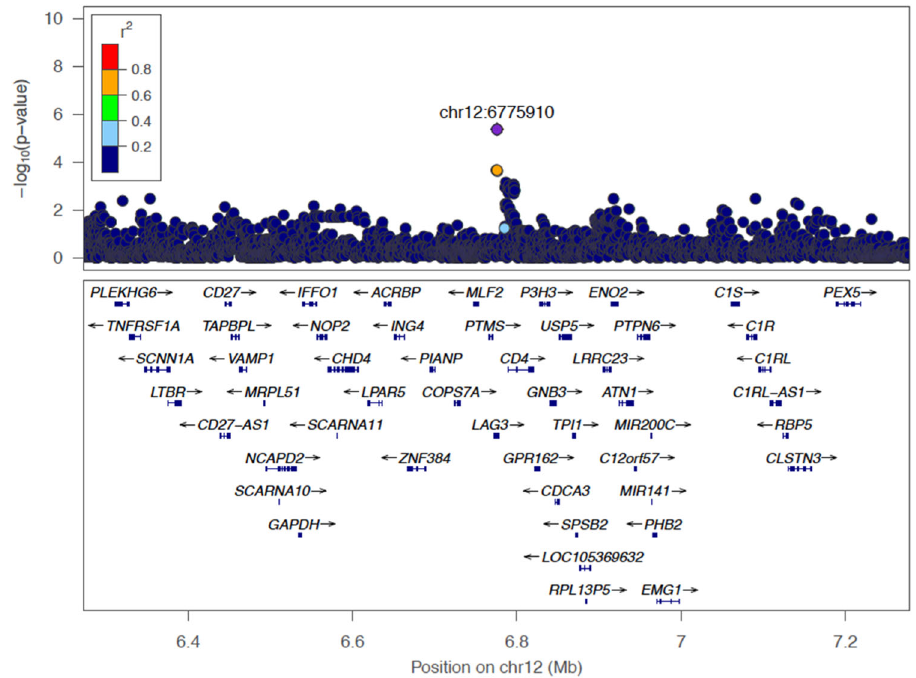
Fig. 1 Regional association plots for statistically signi fi cant genetic association study region based on meta-analysis results of MESA on LAG3 protein levels in Exam 1. The plot presents results for the index variant rs3782735 at chr12:6775910 + /- 250 kb, with linkage disequilibrium determined using the multi-ethnic TOPMed WGS data from MESA.